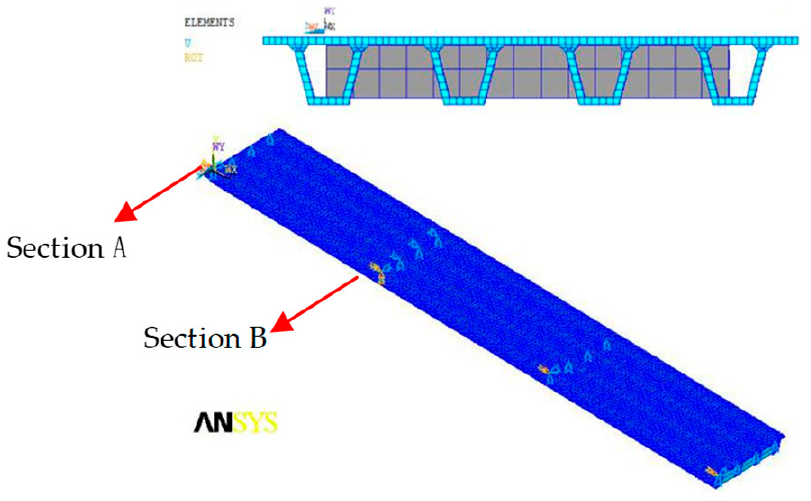
Figure 9. Model of the precast concrete box-gird bridge.